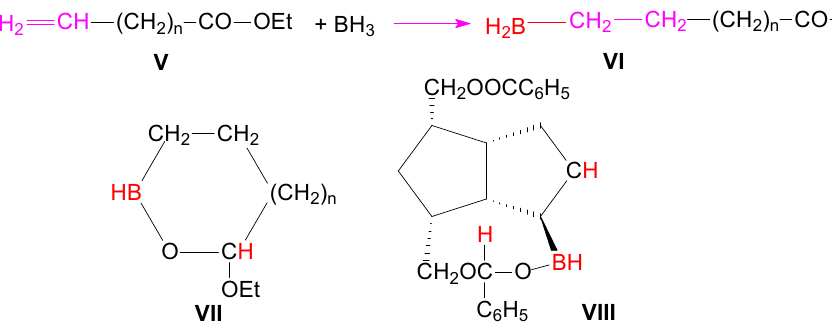
Table 1. Hydroboration of the alkene-diol 7 with borane.